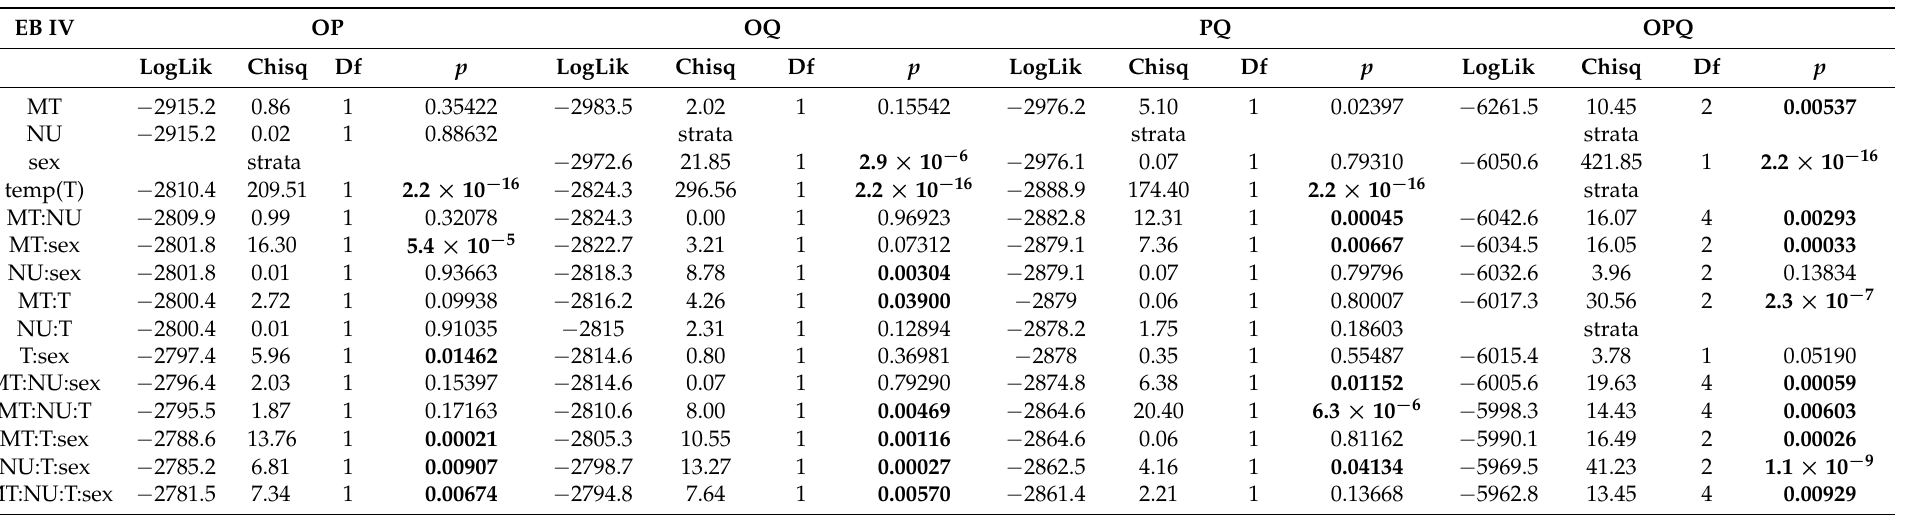
Table 5. The effect of mitochondrial haplotype (MT), nuclear genetic background (NU), sex, temperature (T) and their interactions on desiccation resistance for the experimental block (EB) II of D. obscura . LogLik, log-likelihood; Chisq, chi-squared value; Df, degrees of freedom; strata, variable is stratified; p values that are significant at p < 0.05 are given in